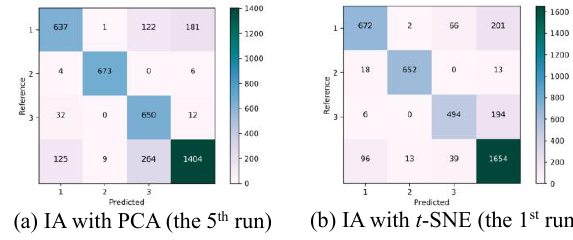
Figure 9 . Confusion matrices of the presented experiments using the IA data set.